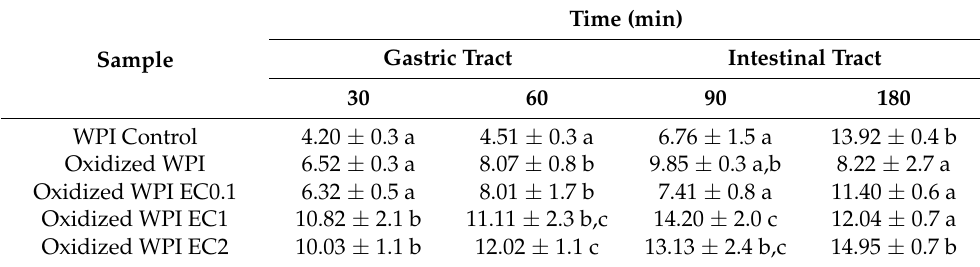
Table 1. Protein hydrolysis (%) of WPI in emulsions containing fish oil in the absence and presence of EC (0.1, 1, and 2 mM). Means ( n = 3) of groups with no common letter in the same columns differ significantly ( p < 0.05).